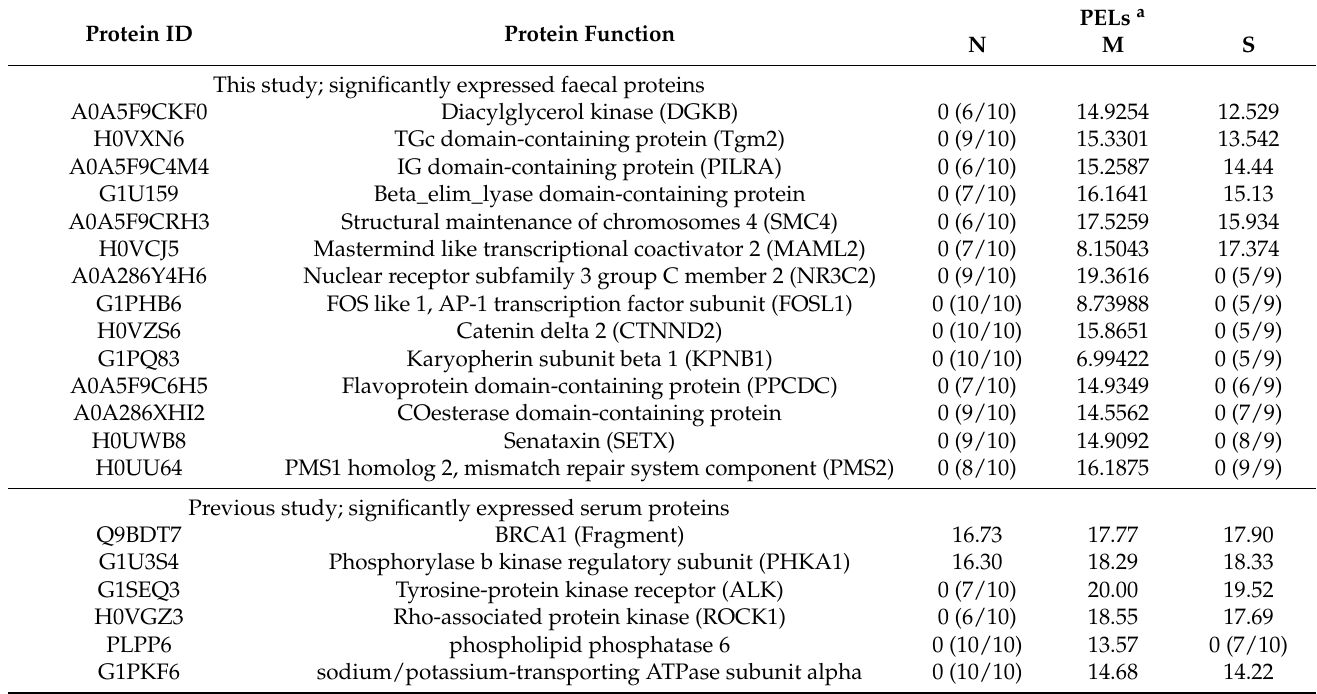
Table 5. Comparative significantly potential proteins of faecal proteome and serum proteome.